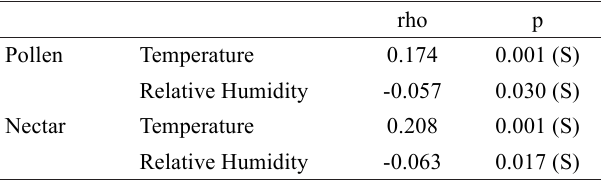
Table 1 . Spearman’s correlation coefficients (rho) for pollen and nectar collection by Melipona quadrifasciata anthidioides foragers and meteorological factors.